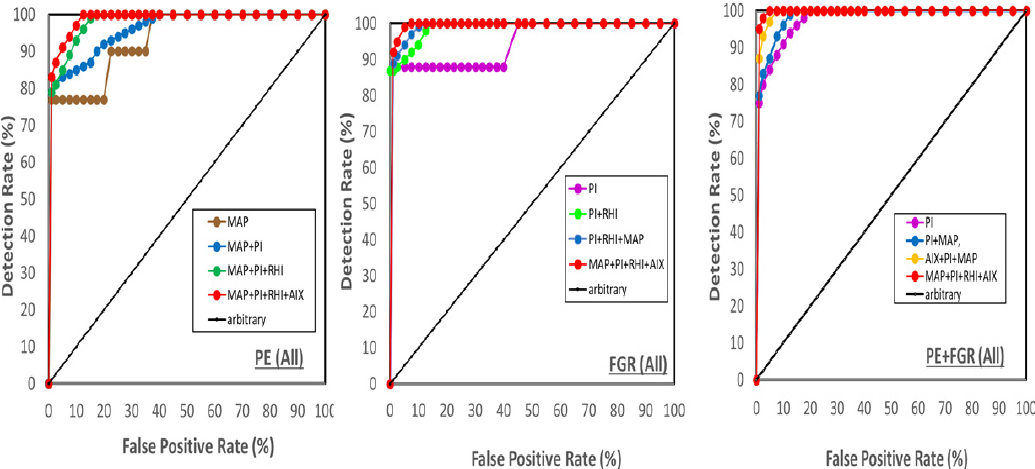
Figure 6. Receiver Operation Characteristic (ROC) curves. ROCs of the area under the curve (AUC) depicted from the detection rate (DR) and the False Positive False Positive Rate (FPR) for All cases of Preeclampsia (PE), FGR, and PE + FGR. ( Left )—PE, ( Middle )—FGR, ( right ) PE + FGR.